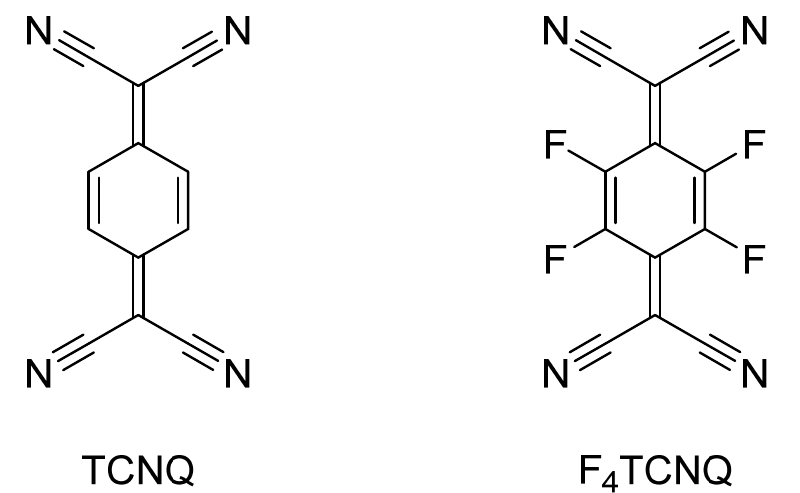
Figure 1. Dinuclear ruthenium-alkenyl complexes with and without laterally-extended π -conjugated arylene ligands.